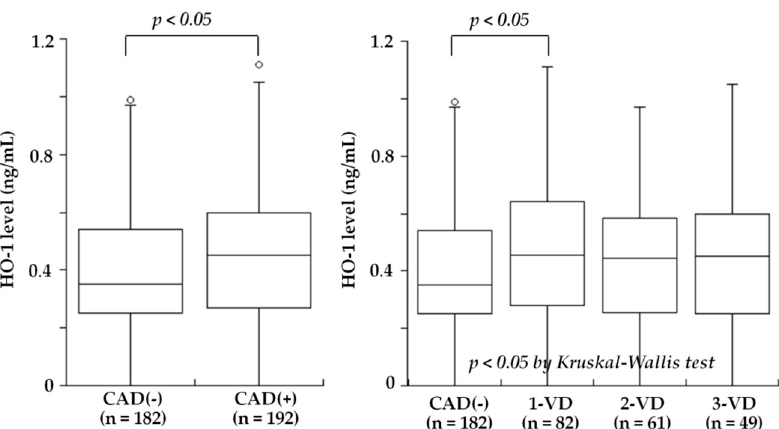
Figure 3. Plasma HO-1 levels and the presence of CAD or the number of stenotic coronary vessels among the 374 patients without PAD. After excluding the 36 patients with PAD, HO-1 levels were significantly higher in patients with CAD than in CAD(-) (median 0.45 versus 0.35 ng / mL, p < 0.05) ( left ). Furthermore, HO-1 levels in the 4 groups of CAD(-), 1-VD, 2-VD, and 3-VD were 0.35, 0.49, 0.44, and 0.44 ng / mL, respectively, and were highest in 1-VD ( p < 0.05) ( right ). The central line represents the median, and the box represents the 25th to 75th percentiles. The whiskers represent the lowest and highest value in the 25th percentile minus 1.5 IQR and 75th percentile plus 1.5 IQR, respectively. (Modified by Kishimoto et al. [26]).